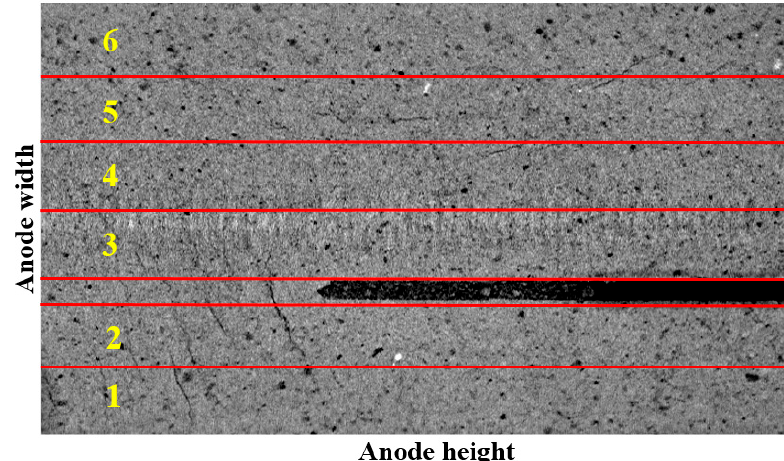
Figure 3. Example X ‐ ray Computed Tomography (CT scan) image obtained for slice number 7. The 6 corridors within the slice are virtually divided by red lines and are identified by numbers 1–6. The black region correspond to one of the anode slot.